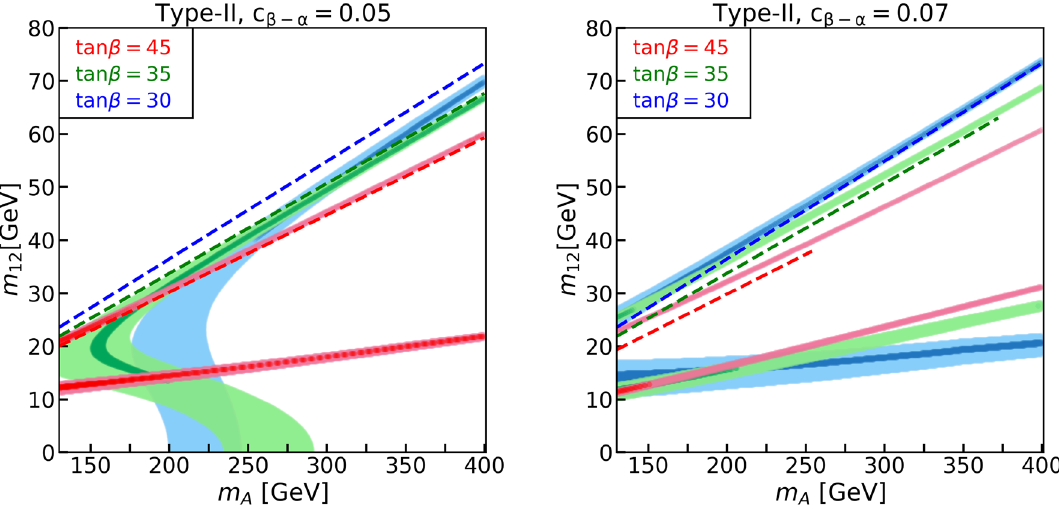
Fig. 6 The allowed region in the plane of m A - m 12 at 95% C.L. for Type-II 2HDM, given LHC Run-II (light color) and HL-LHC (dark color) Higgs precision measurements at one-loop level. Here we take the benchmark parameters m A = m H , m H ± = 600 GeV, cos (β − α) = 0.05 (left), 0.07 (right), tan β = 30 (blue), 35 (green), 45 (red). Gener-